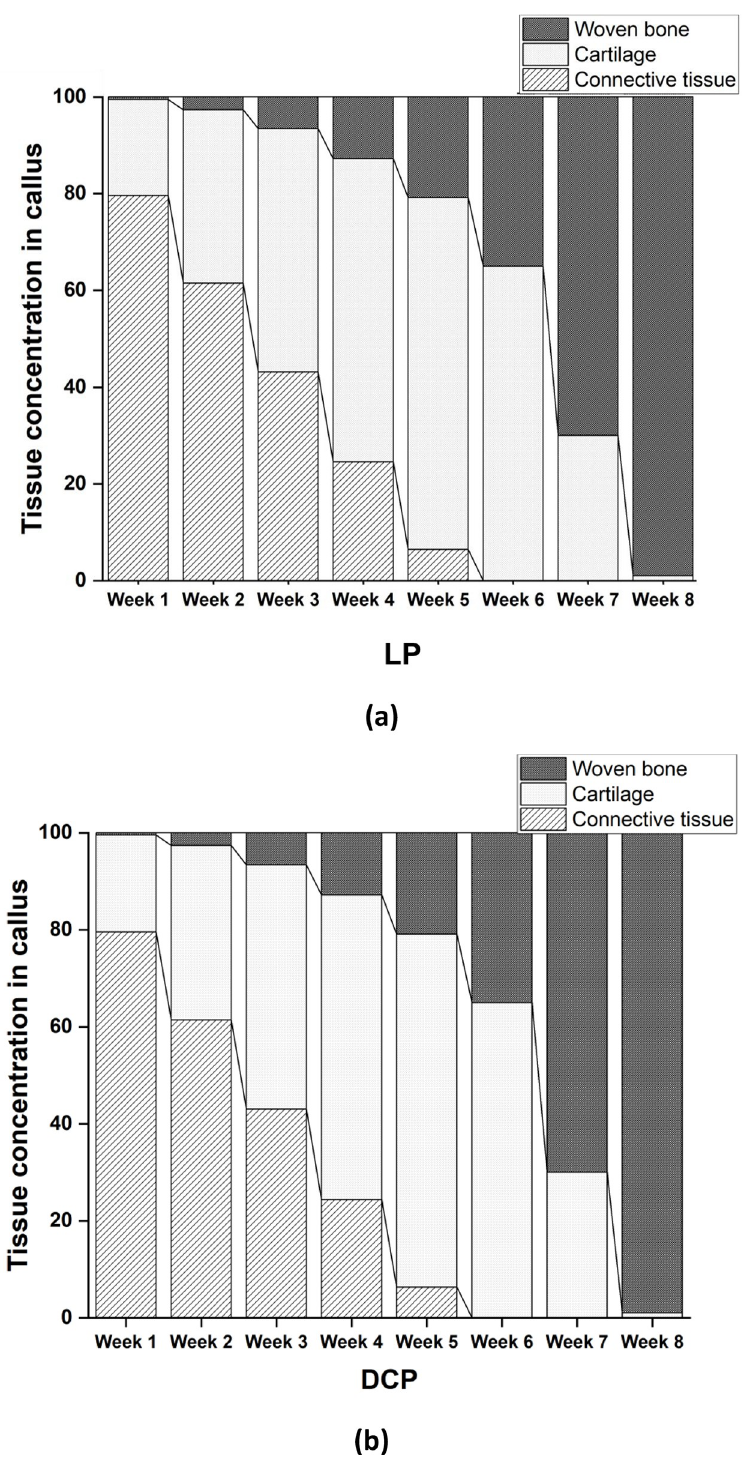
Fig 9. Percentage variation of various tissue concentrations in the callus region from week 1–8 for (a) LP and (b) DCP.